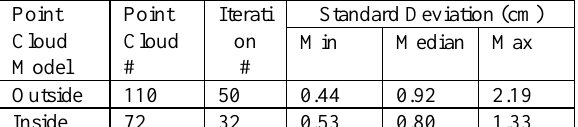
Figure 5. Intersectional (East-West directions) visualization of Semahane (left) and Masjid (right) sections (South side).